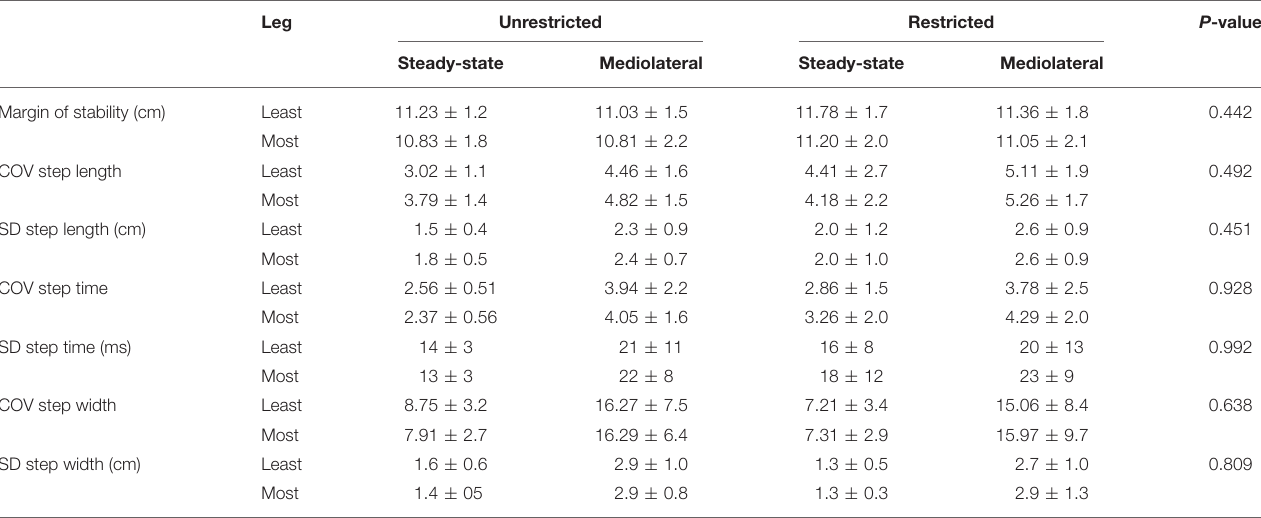
TABLE 2C | Dynamic Stability Measures for arm (unrestricted and restricted) and terrain (steady-state and mediolateral translational) conditions: Margin of Stability and Coefficient of Variation for Step Time, Length, and Width along with spatiotemporal averages. Leg Unrestricted Restricted P -value Steady-state Margin of stability